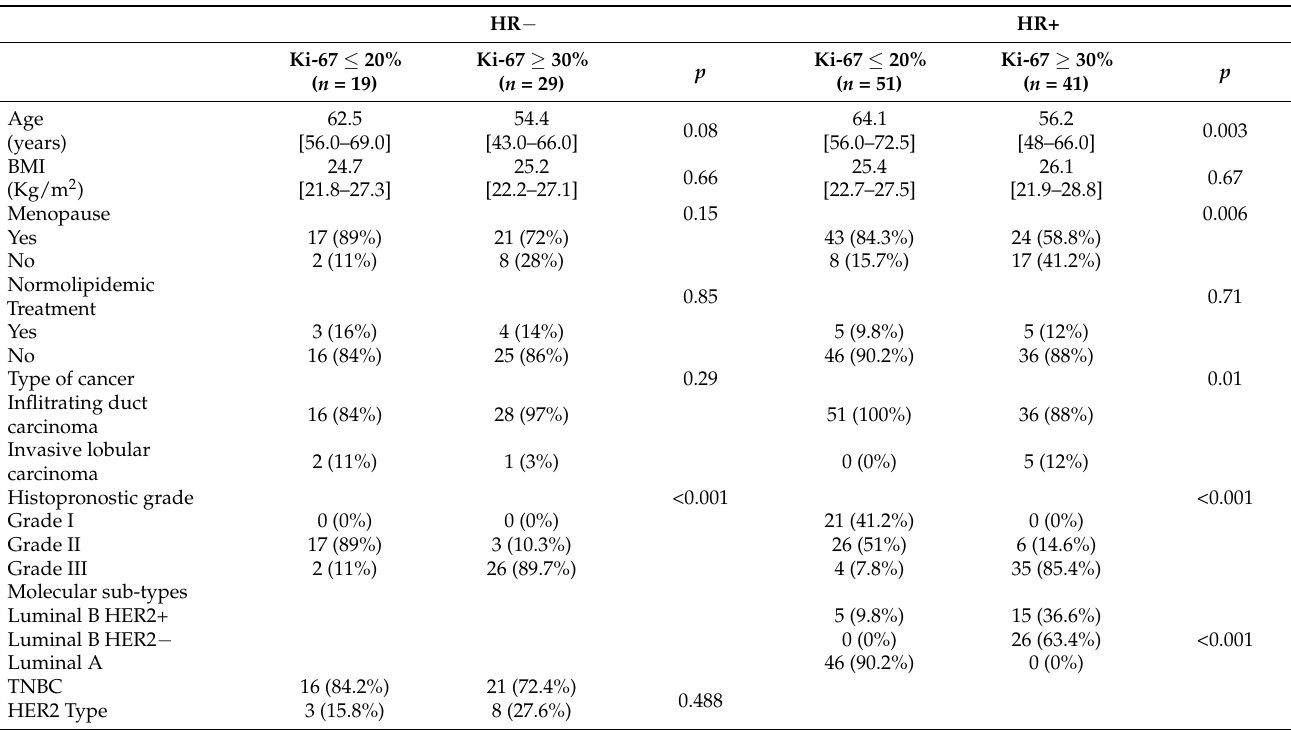
Table 1. Clinicobiological parameters of the studied cohort. Data are presented with median (25th–75th percentile) and frequencies as number